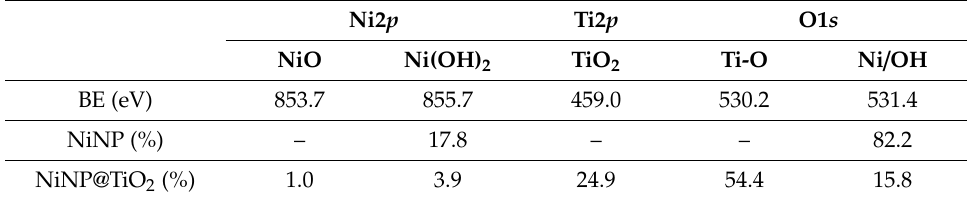
Table 2. Binding energies (BE) of core levels: Ni2p, Ti2p and O1s present for the Ni nanoparticles, and the chemical analysis (in at. %).